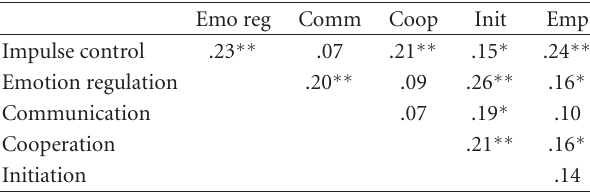
Table 3: Intercorrelations amongst Zoo U